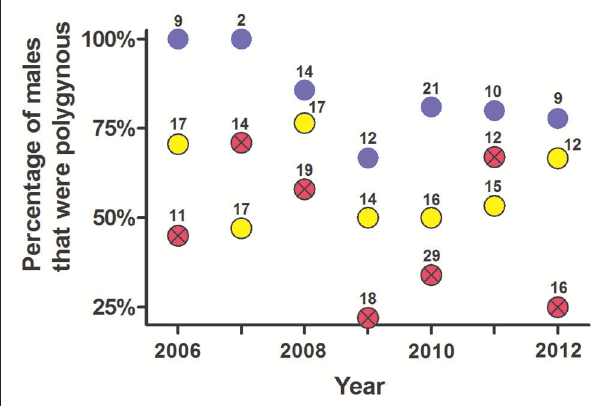
FIGURE 10 | Estimate of the percentage of males per year that were polygynous from (a) social organization, (b) observations of copulations, and (c) probability of genetic non-exclusion analyses from seven polymorphic microsatellites. These data are from male white-tailed prairie dogs at the Arapaho National Wildlife Refuge, Colorado USA, from 2006 through 2012. Yellow circles are from composition of clans (mean ± SE estimate of males that were polygynous = 59% ± 4.5%); blue circles are from observations of copulations (mean = 84% ± 4.6%); red circles with Xs are from probability of genetic non-exclusion (mean = 46% ± 7.5%). The number above each dot indicates the number of males for which we had information for each